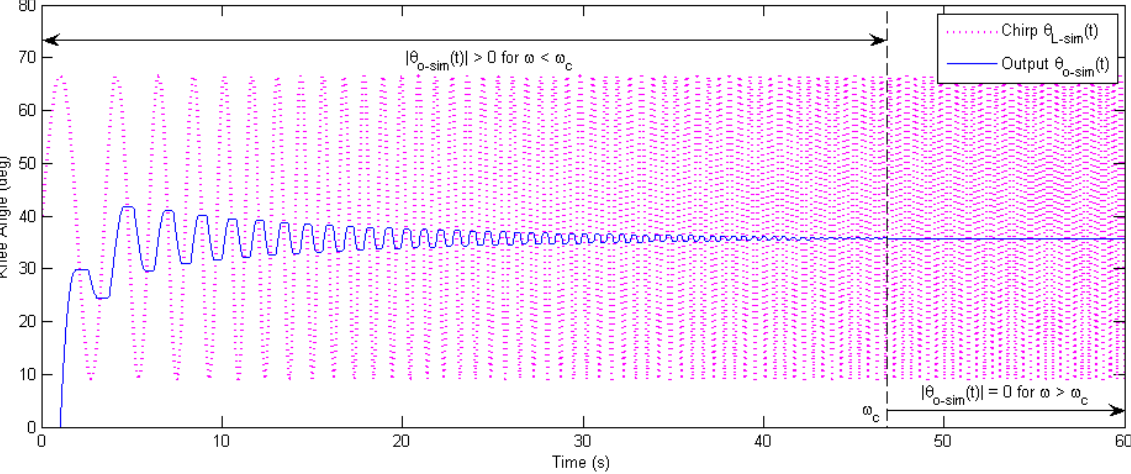
Figure 10. Sinusoidal response of a linear chirp signal based on the Matlab Simulink model. The frequency 𝜔 of the chirp input 𝜃 𝐿−𝑠𝑖𝑚 (𝑡) varies linearly from 0.2174 Hz to 2.6187 Hz for time 𝑡 = 0 s to 60 s . Due to friction and backlash in the Bowden cable and gear reducer, the simulated output knee angle |𝜃 𝑂−𝑠𝑖𝑚 (𝑡)| = 0 for 𝜔 > 𝜔 𝑐 = 2.0986 Hz (where other parameters are consistent with those in Figure 7).